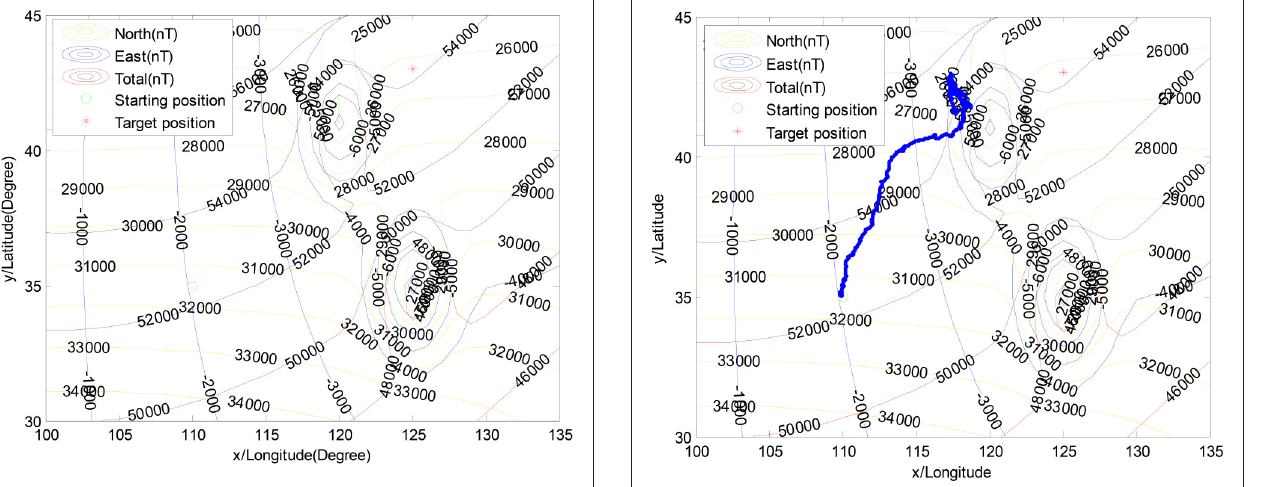
FIGURE 3 | The simulation scenario within multi-modal function.